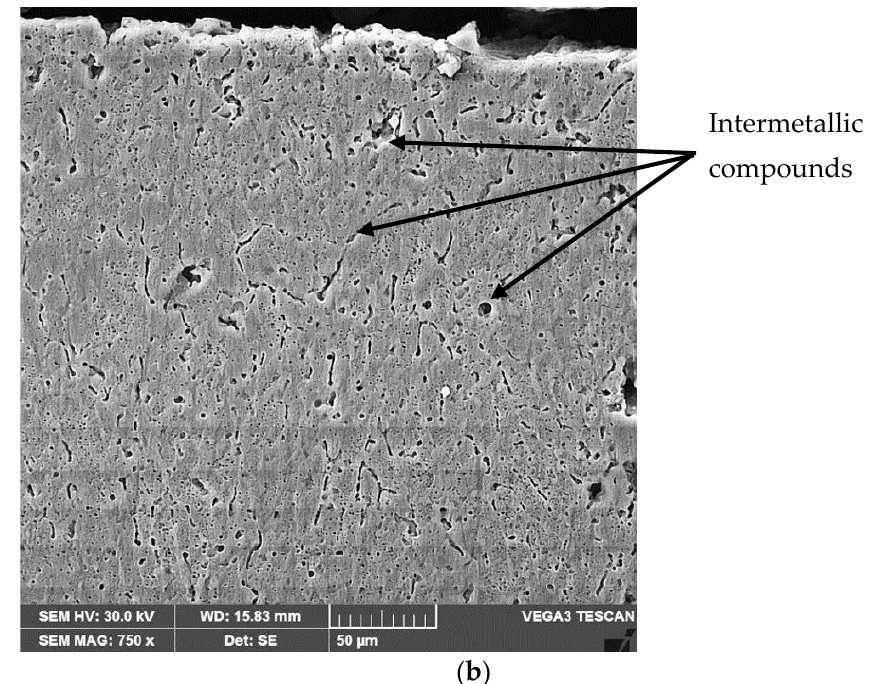
Figure 10. Microscopic images of a cross section through the remelted layer, with Is = 200 A: ( a ) OM ×200; ( b ) SEM ×750.